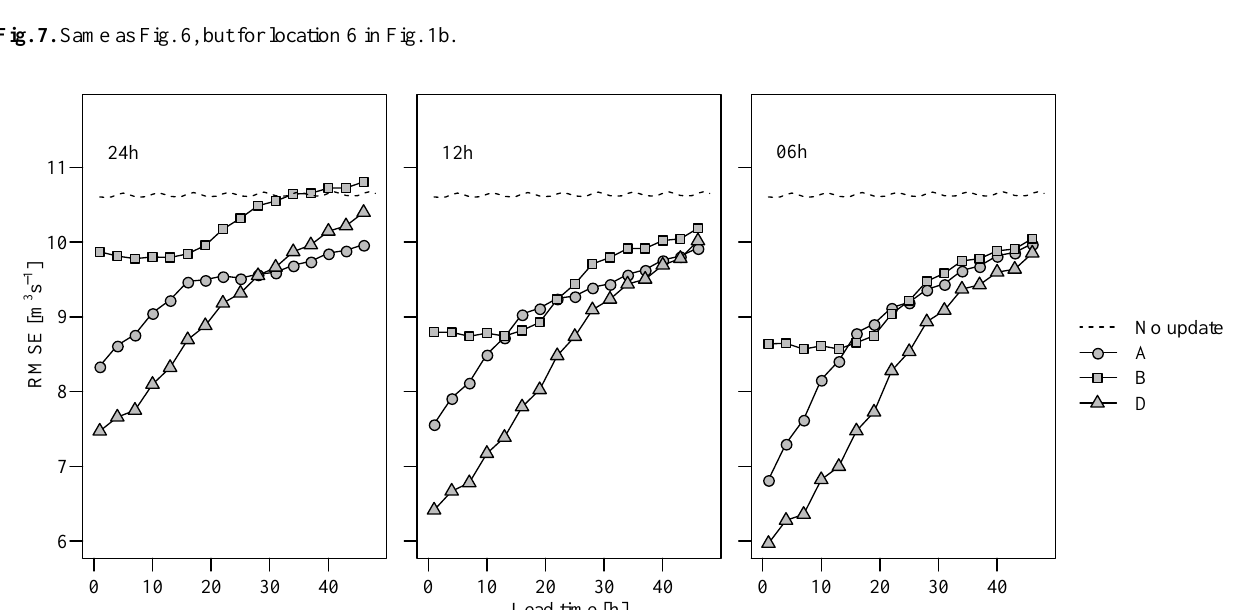
Fig. 8. Real world experiment, simulation period from 15 August 2002 to 15 January 2003. Root-mean-square error at Tabreux for different discharge observation vectors. Forecast issued every 6h. EnKF assimilation every 24h (left), 12h (centre), 6h